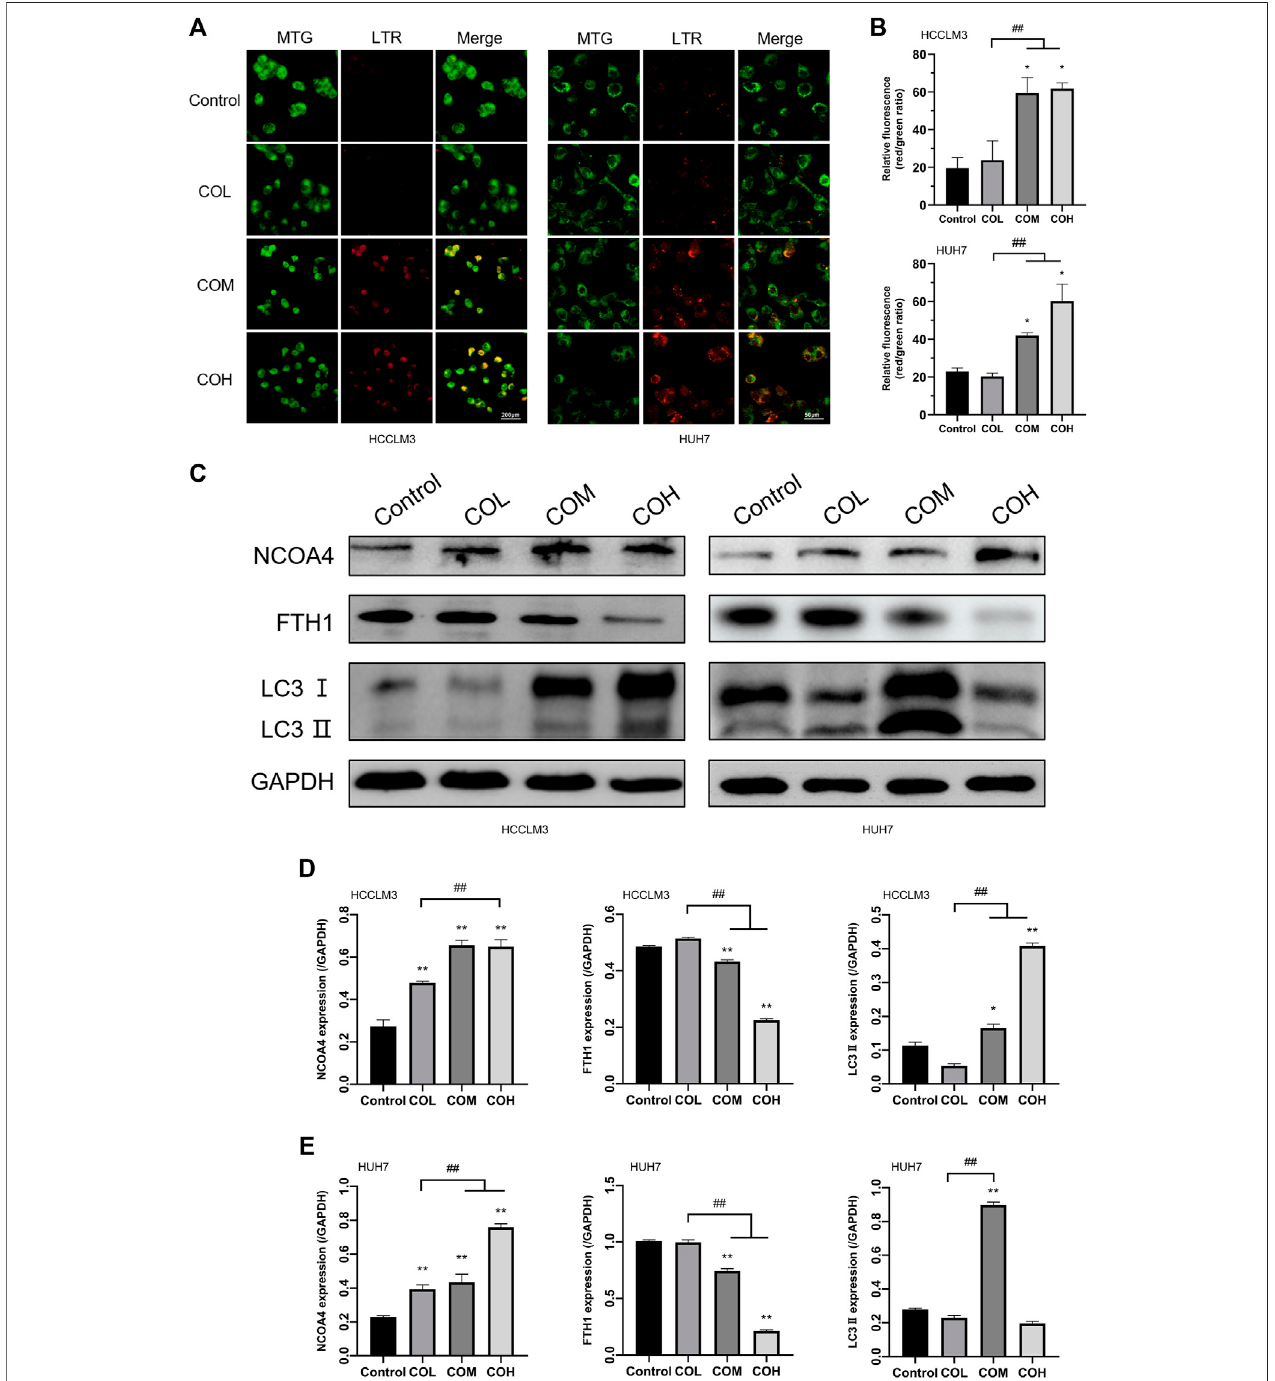
FIGURE5| Effects ofcaryophylleneoxide onlysosome and ferritinophagyinHCCLM3and HUH7 cells. (A) Lyso-Tracker Red andMito-Tracker Green co-staining toinvestigate theautophagy – lysosomesituationinHCCLM3andHUH7cellsand expressed as (B) , (C) .Westernblotanalysisrevealedtheexpression offerritinophagy- related proteins in HCCLM3 and HUH7 cells, which were expressed as (D) , (E) . * p < 0.05, ** p < 0.01 when compared to the control group. # p < 0.05, ## p < 0.01 when compared to the COL group.